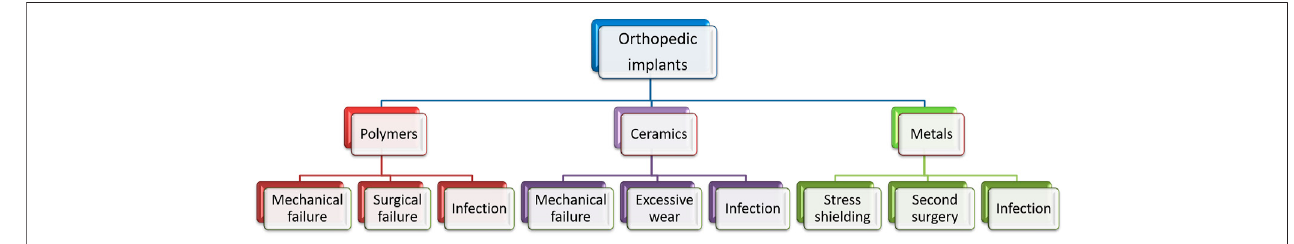
FIGURE 1 | Limitations of conventional materials for degradable orthopedic